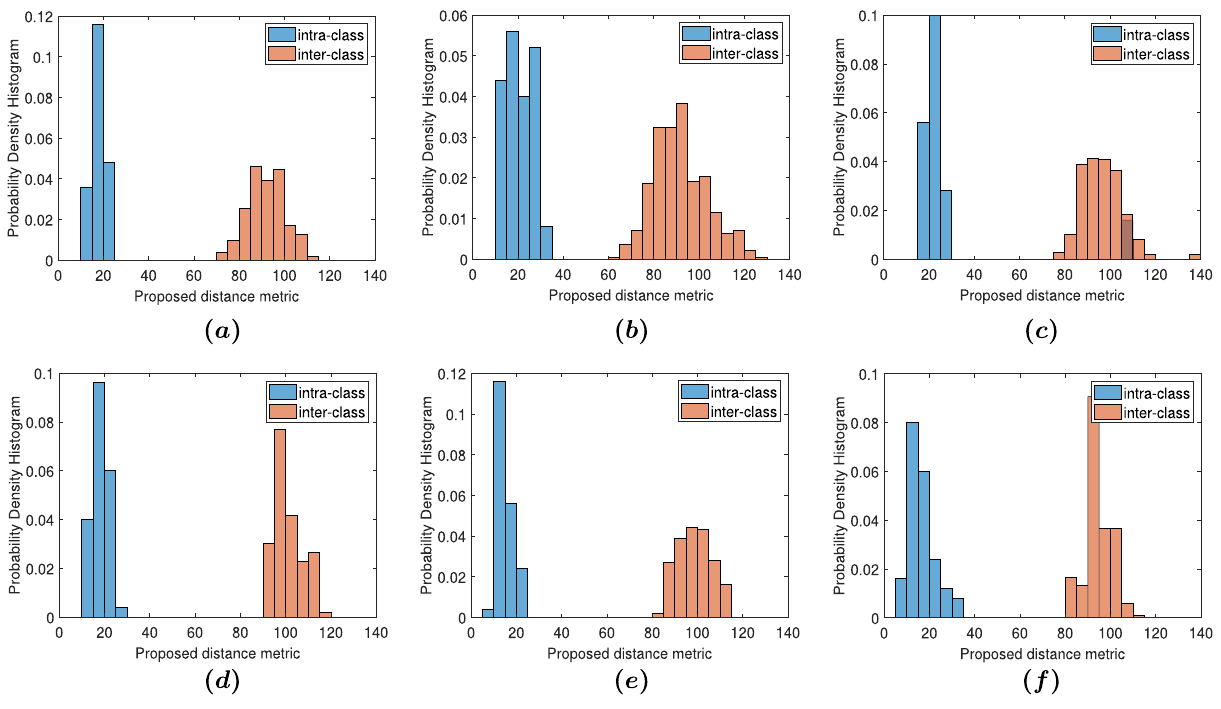
Figure 4. Histograms of inter- and intra-class distance for 3 Engravings of beam Splitter ( a – c ) and beam Diffuser ( d – f ) CGH-PUFs, considering the best case ( a , d ), the worst case ( c , f ) and a randomly selected average case ( b , e ) based on their POC